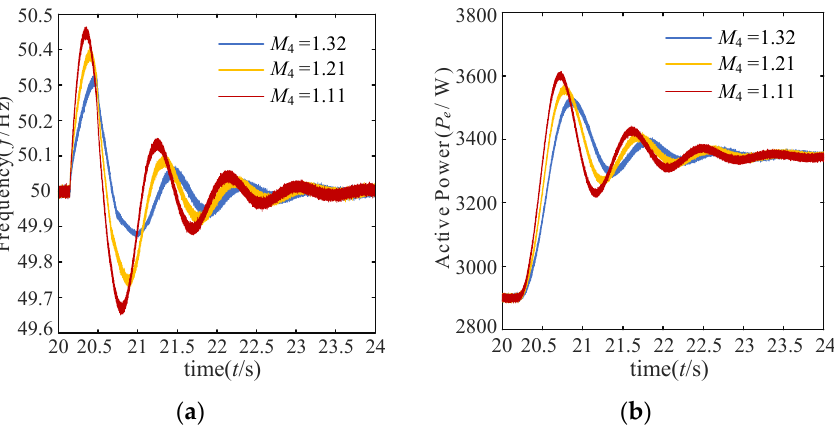
Figure 13. The influence of control parameter M 4 variations on the system: ( a ) System frequency waveforms; ( b ) Output waveforms active power.